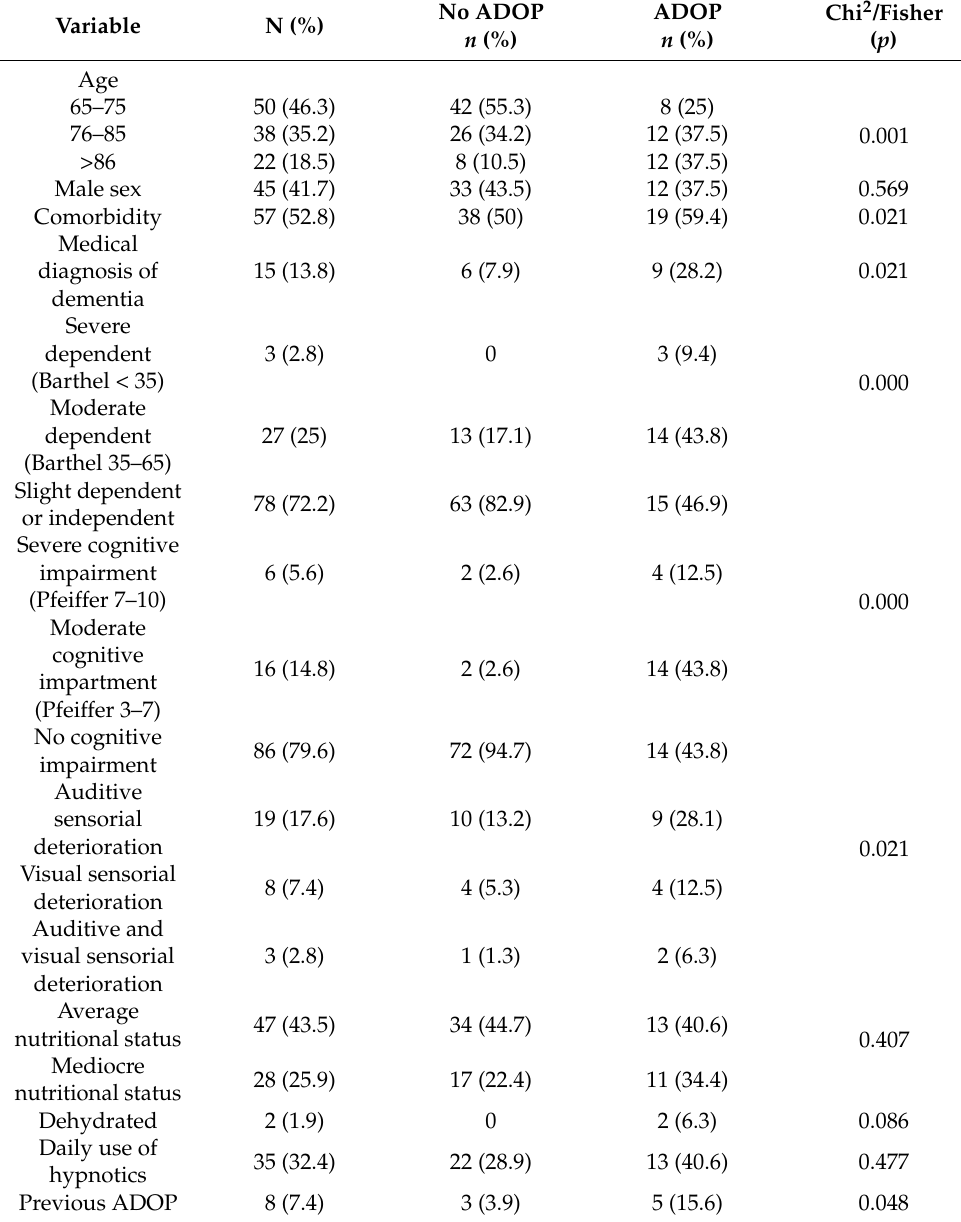
Table 2. Association between predisposing factors of ADOP and ADOP during hospital